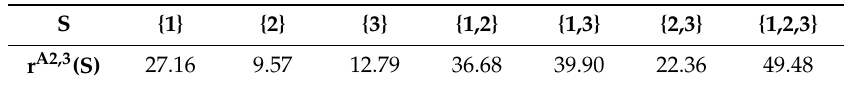
Table 11. Coalitional costs in the game ({1,2,3},r A2,3